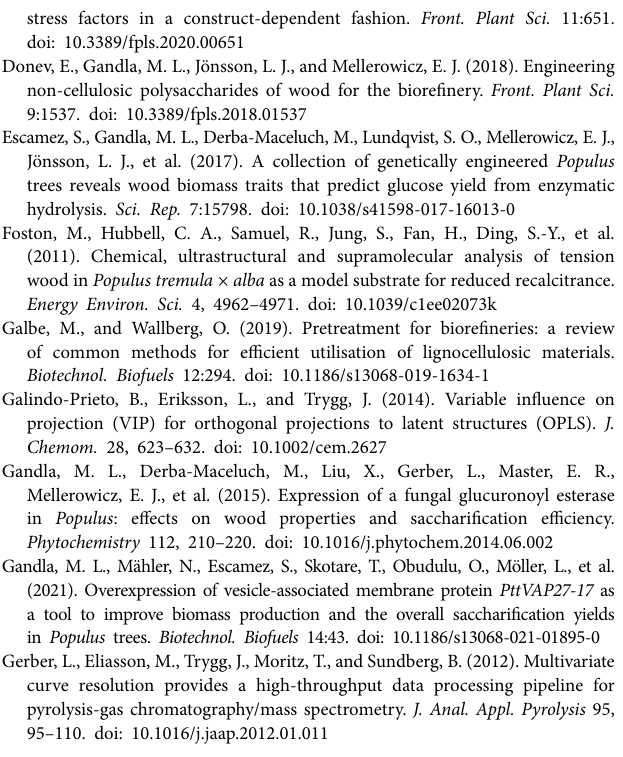
FIGURE 8 | (D) “tree glucose yield” in PT. For each model, an orthogonal projections to latent structures scatter plot showing the distribution of aspen samples (dots) colored according to constructs is presented on the left. The horizontal axes show spreads of samples according to the predictive component while the vertical axes show spreads along the orthogonal component not correlating with glucose yields. Orthogonal projections to latent structures loading plots of the respective models are shown on the right. Loadings marked with stars are important for the predictive component (VIP predictive >1) and significantly contribute to the total model (VIP total – 95% confidence interval > 0). PL, pretreatment liquid; EH, enzymatic hydrolysis; Y, yield; and GPR, glucose production